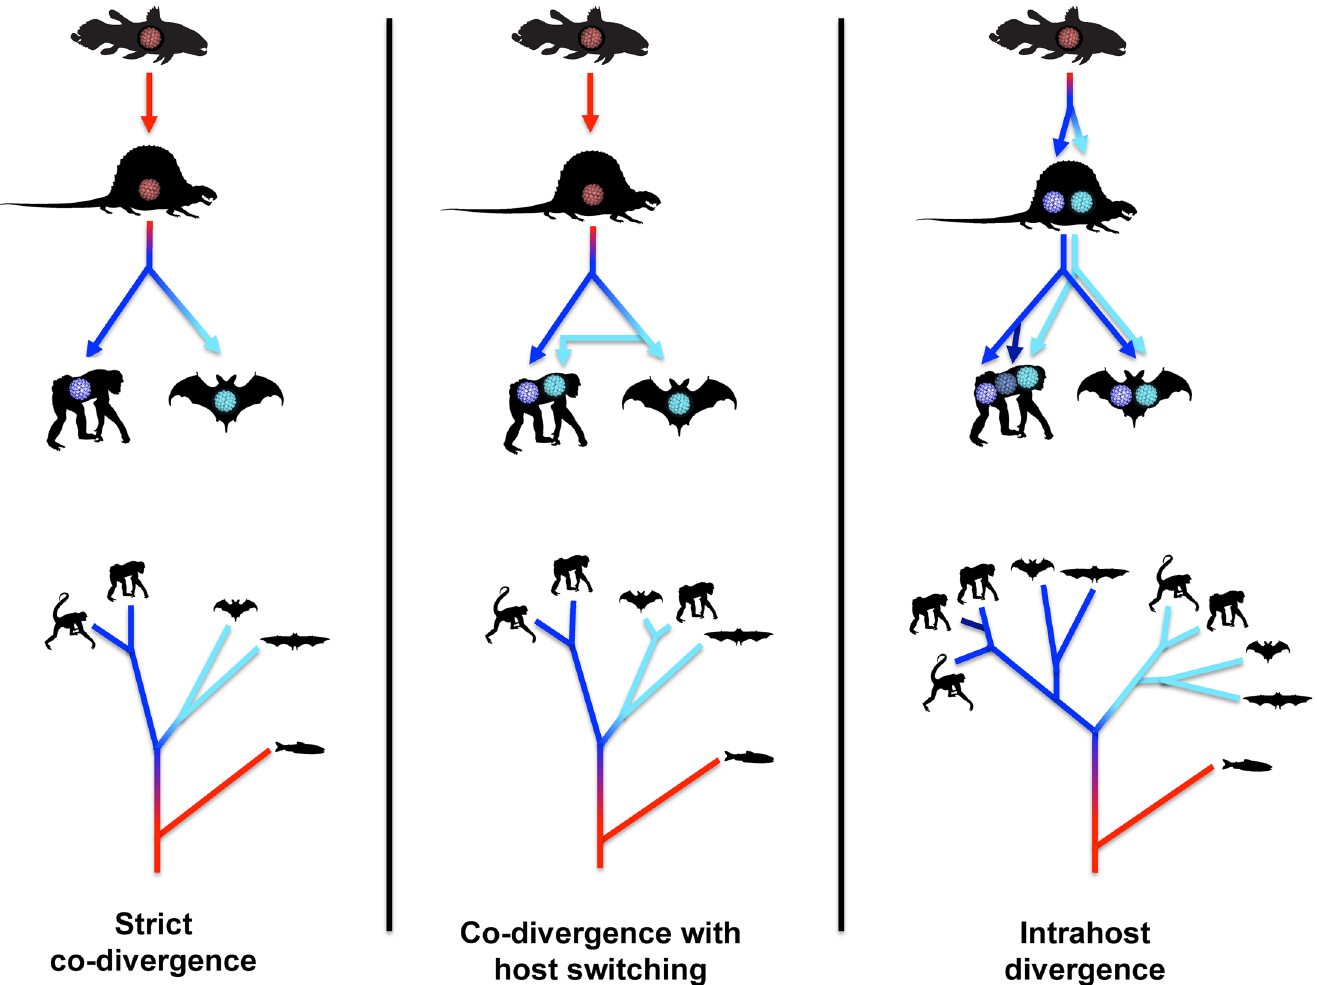
Fig 6. Standard virus/host co-divergence models. The top panels depict the evolution of polyomaviruses within animal lineages. Idealized cartoon trees in the bottom panels represent the expected polyomavirus phylogeny. The silhouettes in the bottom panels represent the animal type in which the polyomavirus at the branch tip would be